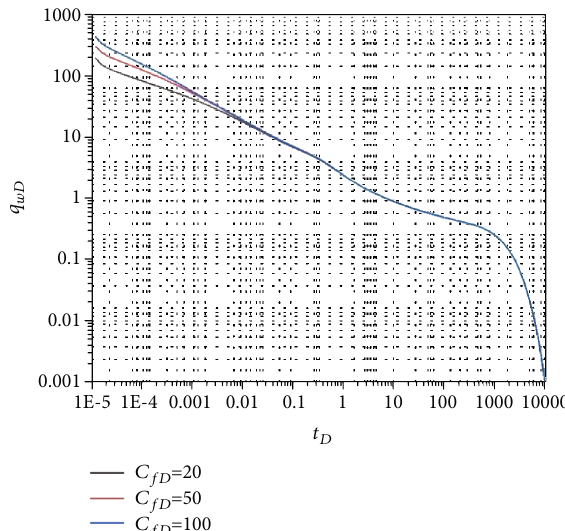
Figure 10: In fl uence of initial fracture conductivity on production.